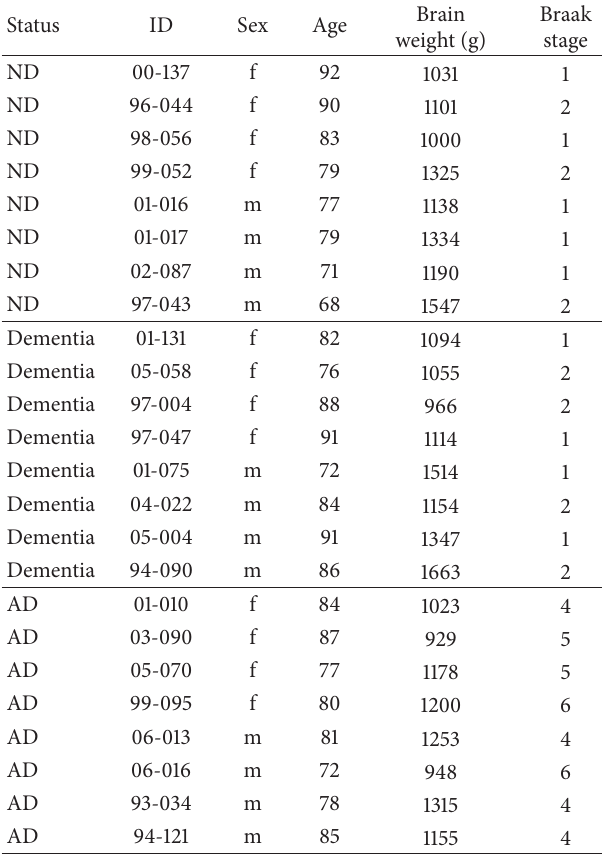
Table 1: Summarized patient data for the 3 cohorts of human brain